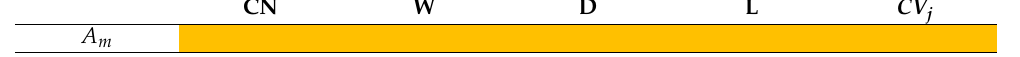
Table 3. The pattern of wins, draws, losses, and comparison values in ARPASS. CN